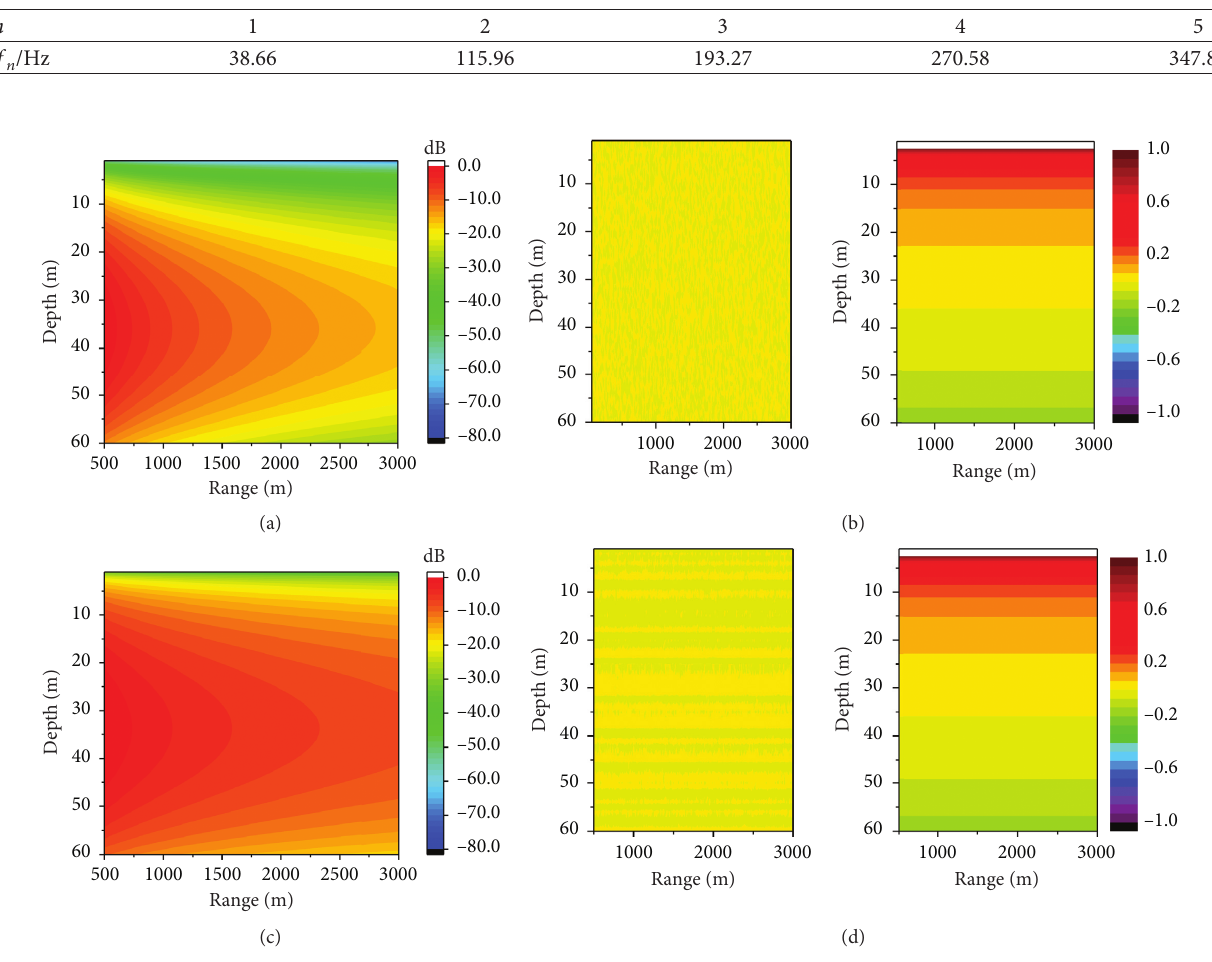
Figure 9: (a) Normalized | p 2 | field of a unit point source. (b) Normalized acoustic intensity field of the unit point source (left: I ∗ (c) Normalized | p 2 | field of a cylindrical shell. (d) Normalized acoustic intensity field of the cylindrical shell (left: I ∗ z ; right: Q ∗ z ) ( h U � 20m, f � 50 Hz). 0